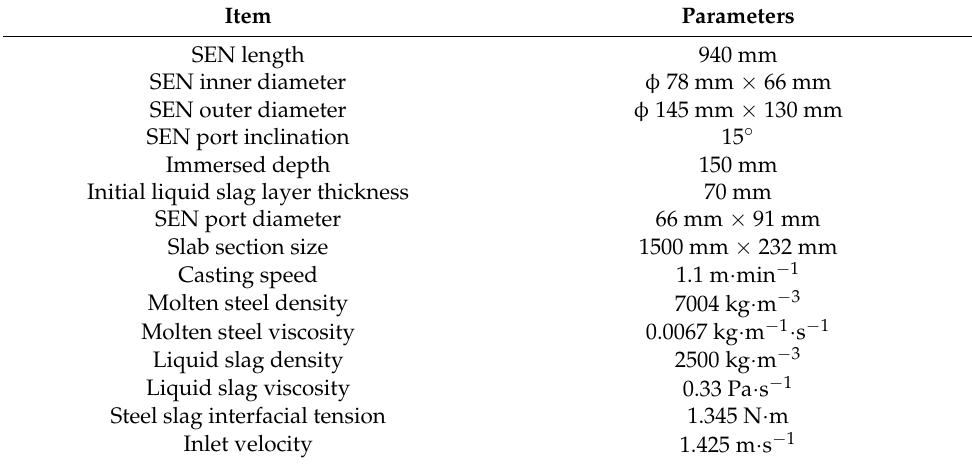
Table 2. Main dimensions and parameters.